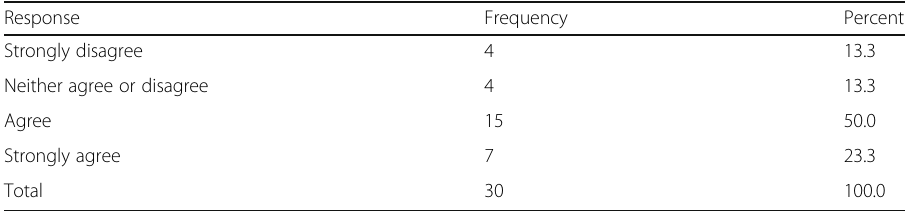
Table 6 Increase quality of road infrastructure